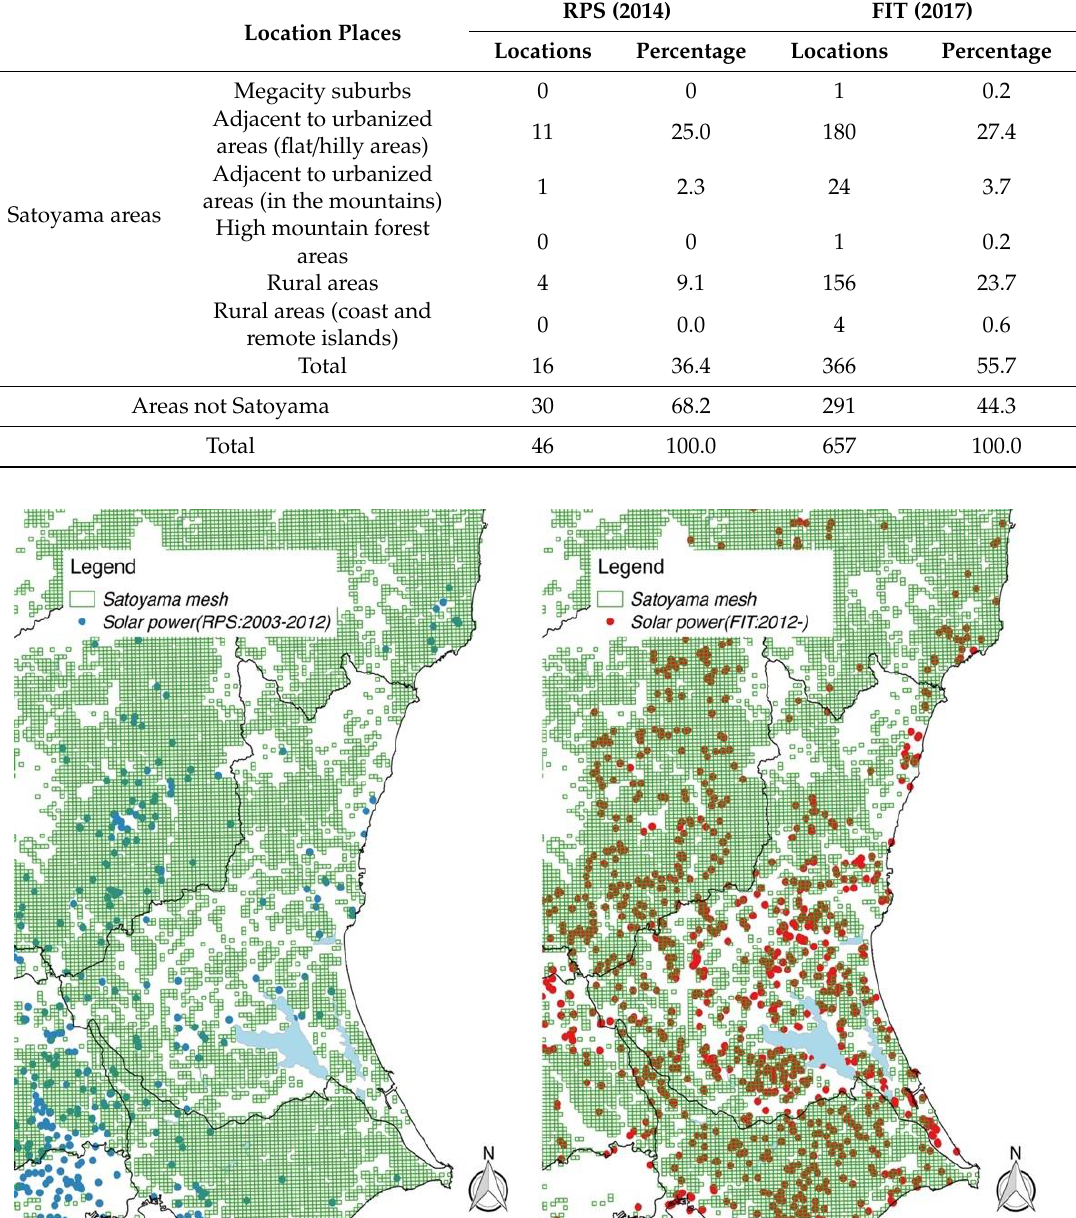
Table 3. Locations of the solar power facilities based on the RPS and FIT in the Ibaraki Prefecture. Source: Collected and processed by the authors.